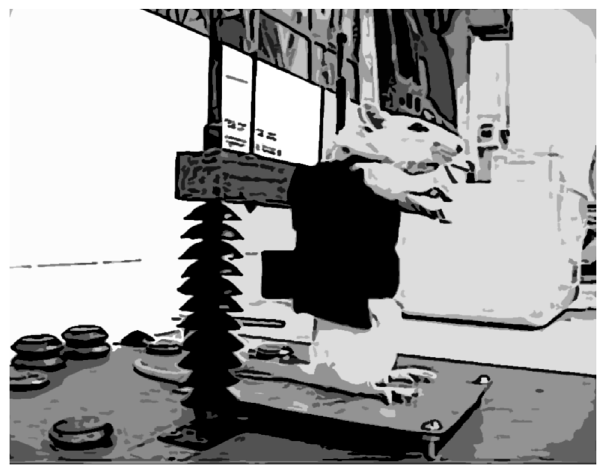
Figure 1. Representative illustration of the apparatus used for resistance